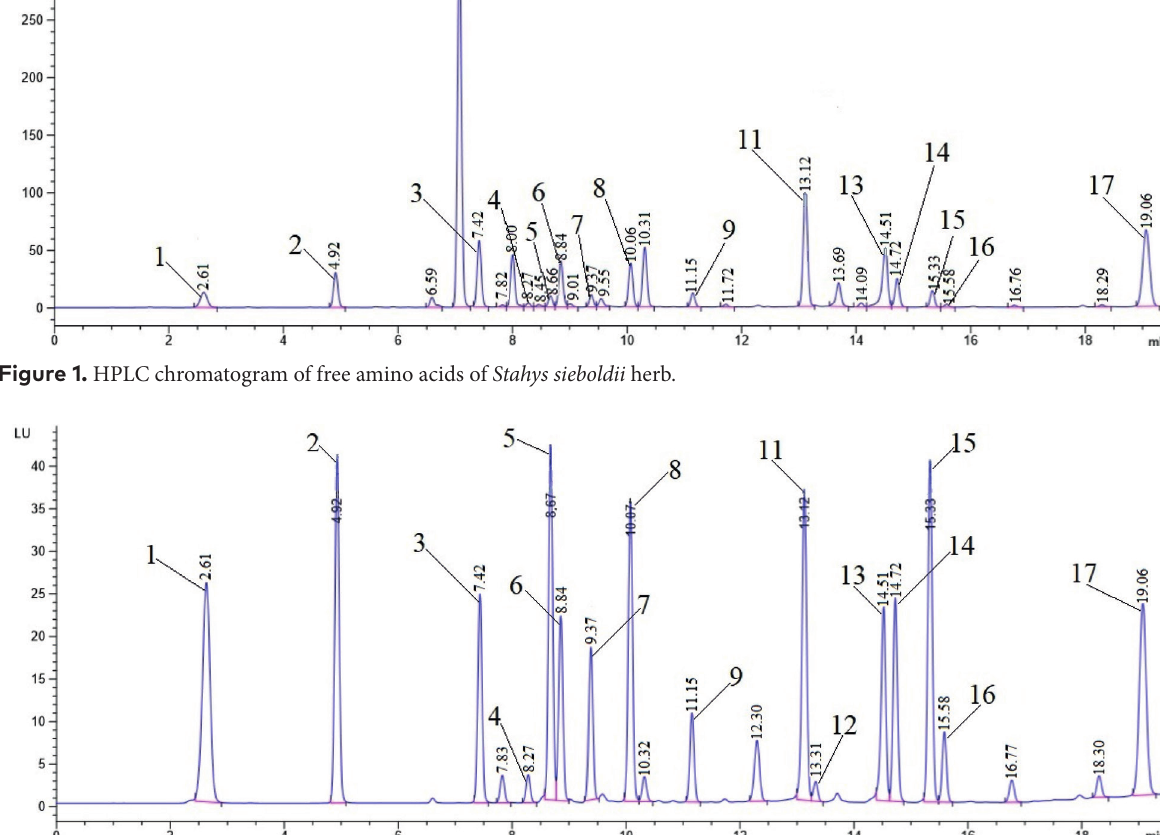
Figure 2. HPLC chromatogram of amino acids after hydrolysis of Stahys sieboldii